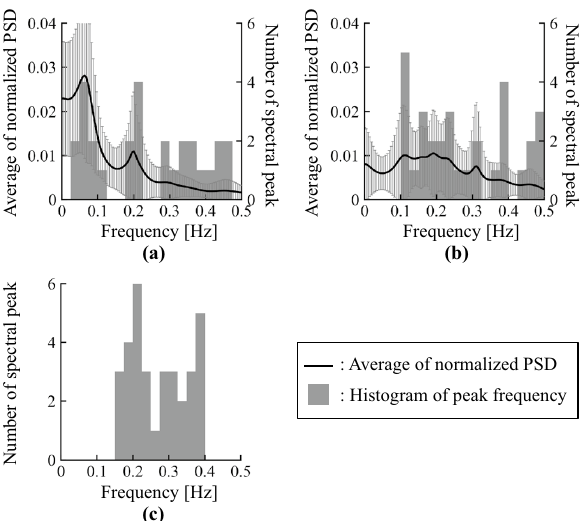
Figure 5. Averages of normalised PSD and histograms of peak frequency for peripheral arterial stiffness β for all subjects: ( a ) pre SNB, ( b ) post SNB, ( c ) sum of pre SNB and post SNB measured at high frequency range